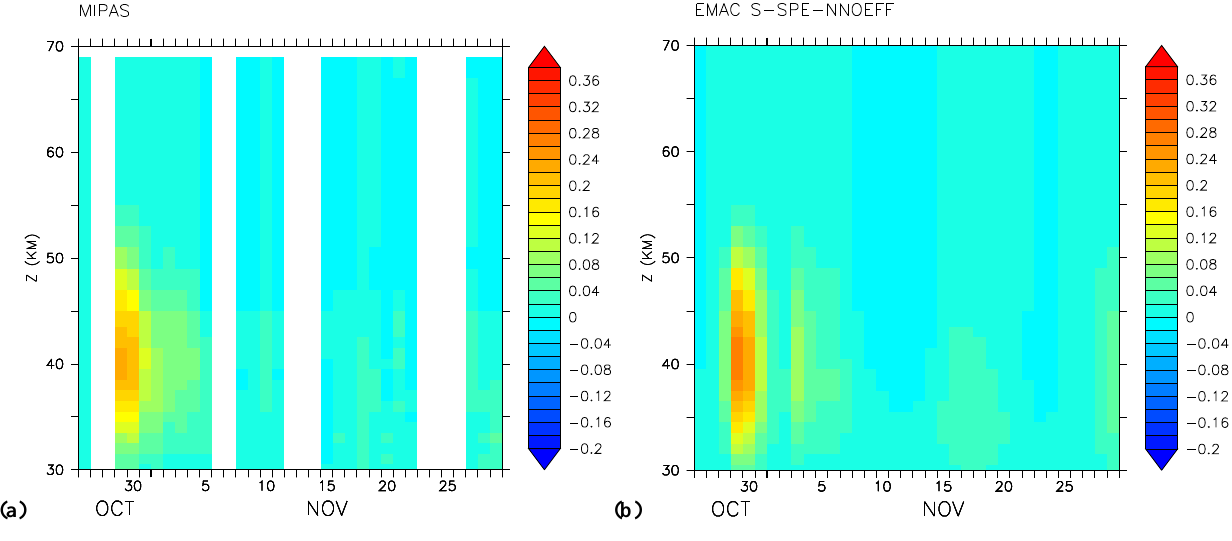
Fig. 15. HOCl changes (ppbv) for 70–90 ◦ N relative to 26 October 2003; (a) MIPAS, (b) EMAC simulation S-SPE-NNOEFF.